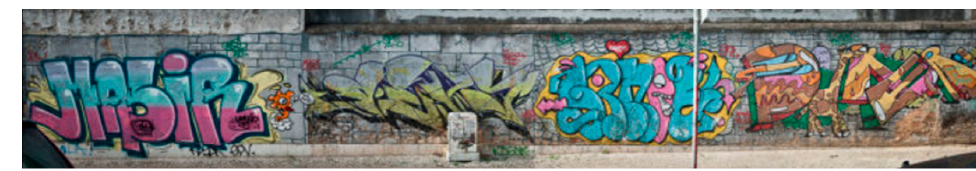
Figure 14. Images labeled as street art.